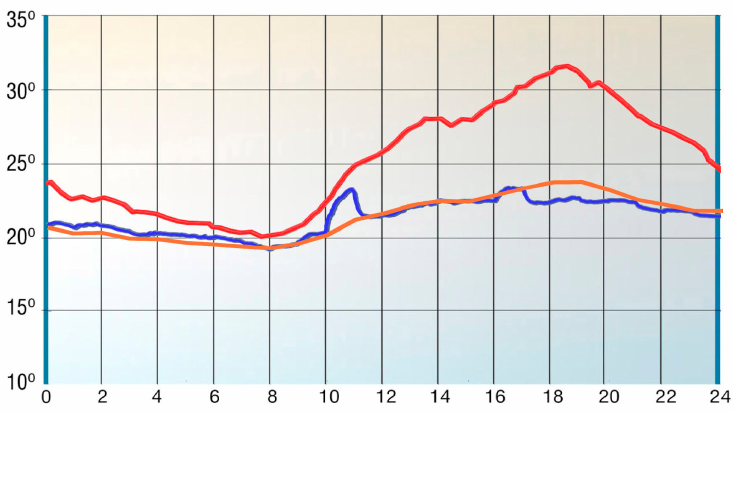
Figure 20. Red: Outside monitored temperature on the 27th April 2010. Blue: Monitored temperature in the courtyard on the 27th April 2010. Orange: numerical